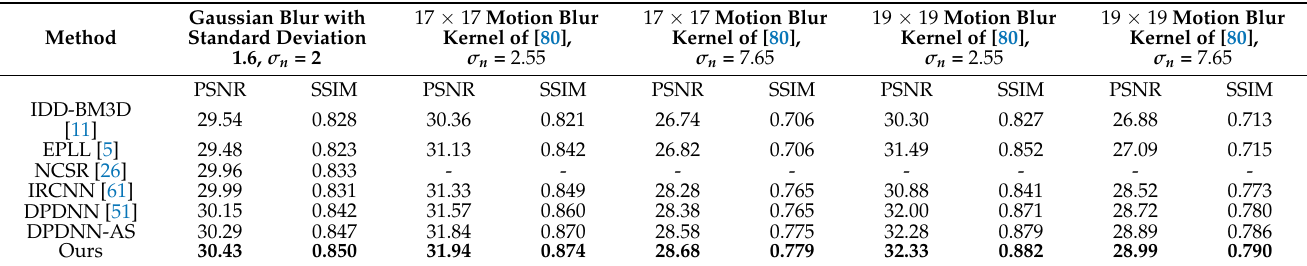
Table 6. The Average PSNR Values of The Test Methods For Deblurring on The Kodak24 Dataset.